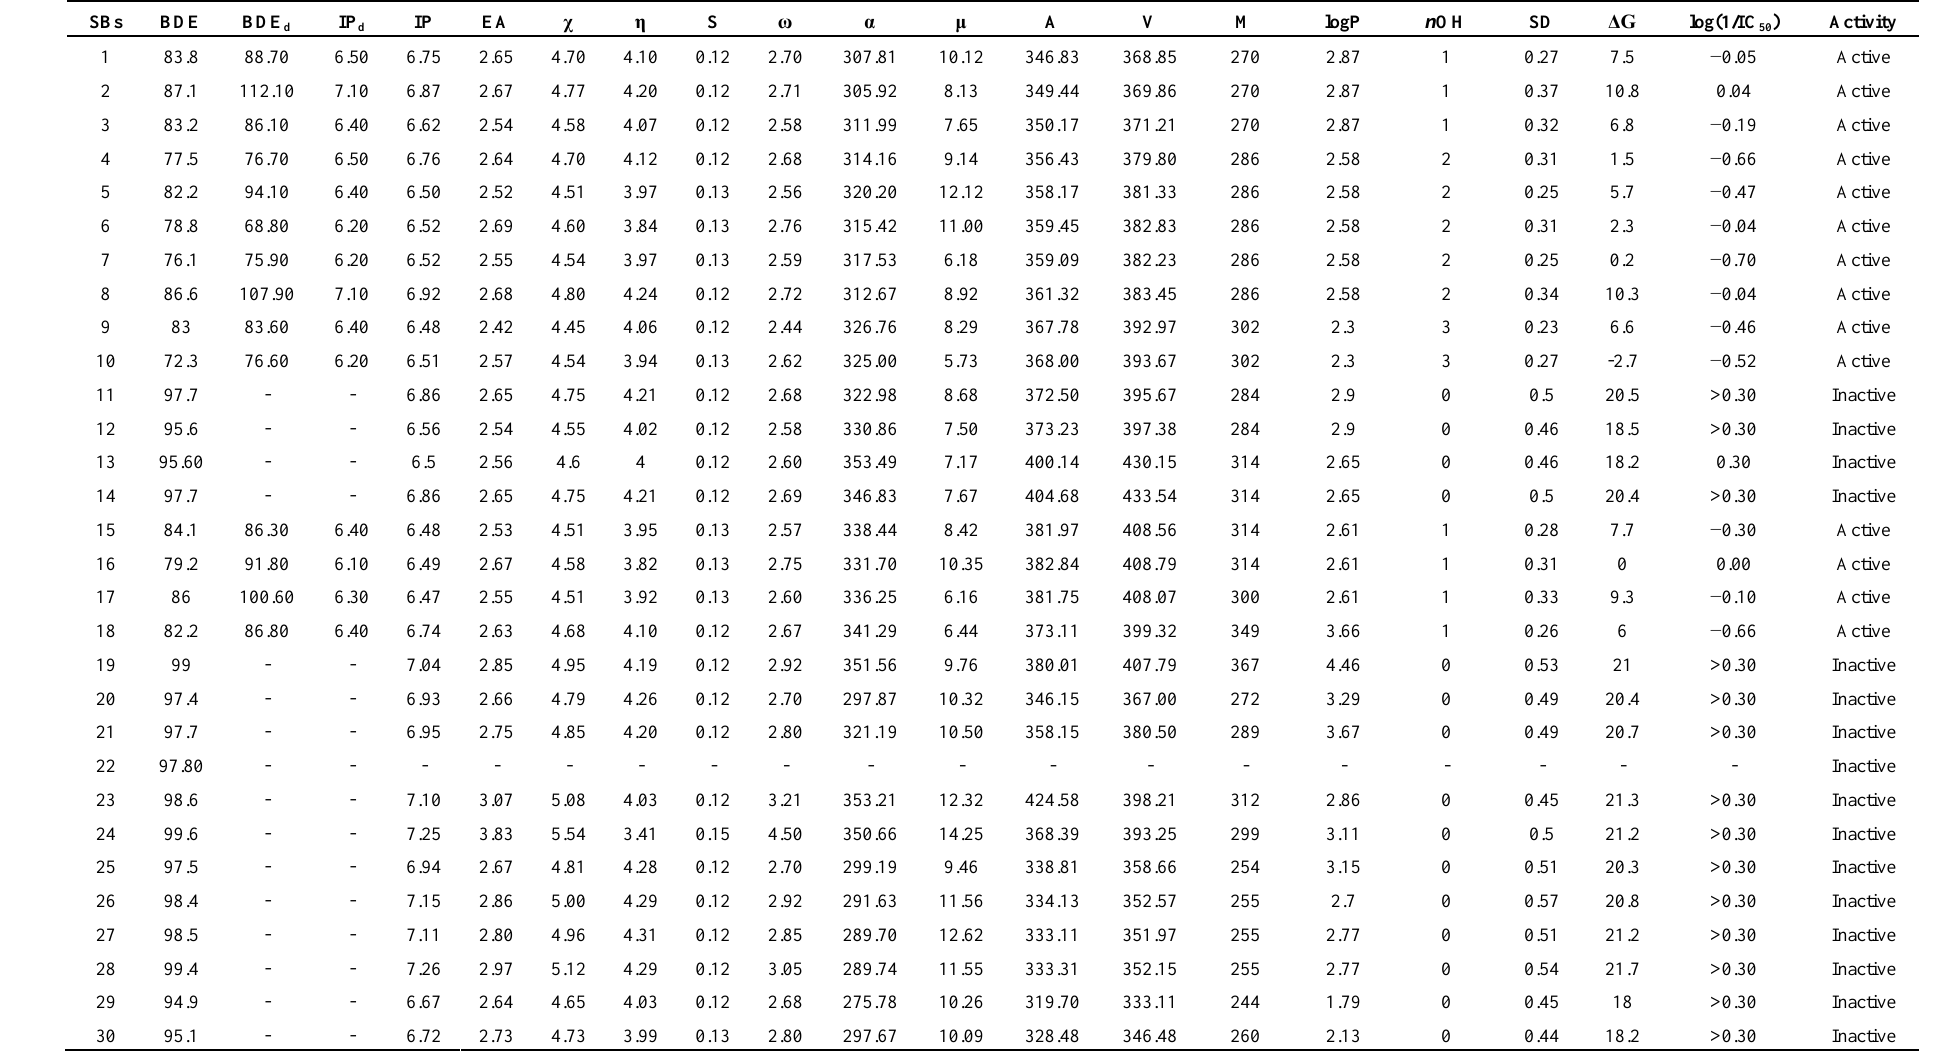
Table 2. Values of the calculated descriptors and the antioxidant activity of Schiff bases (SBs). BDE, bond dissociation enthalpy; IP, ionization potential; EA, electron affinity; S, softness; A, surface area of the molecule; V, volume; M, molecular